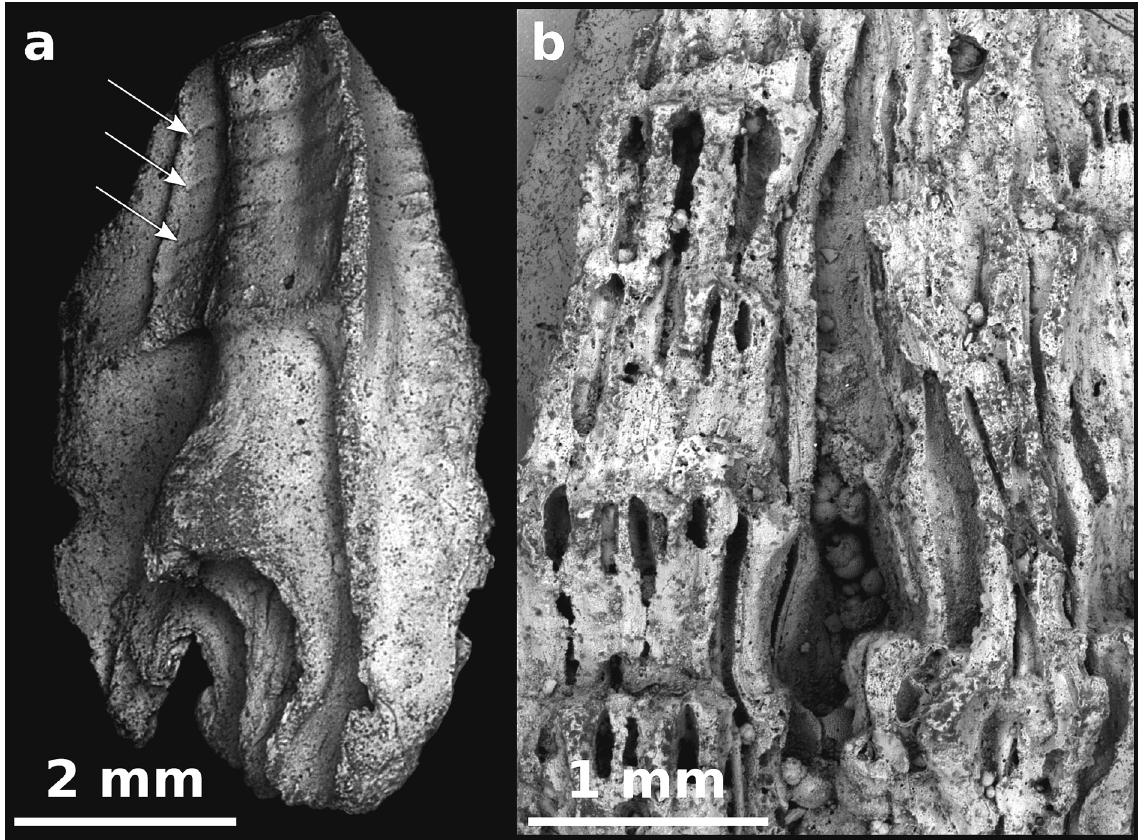
Fig. 3. † Platylepas mediterranea sp. nov., holotype (MSNC 4562). a . Interno-alar view. Note the strongly appressed sheath exhibiting distinct transverse grooves (arrows) and the short, triangular, wedge-like, transverse septa on the sutural edge of the alar portion of the compartment. b . Close-up of the outer surface of the compartment. The outer lamina is only locally preserved; where it is eroded, longitudinally elongated septa and canals are visible. The intersection between longitudinal septa and transverse growth ridges is occasionally marked by